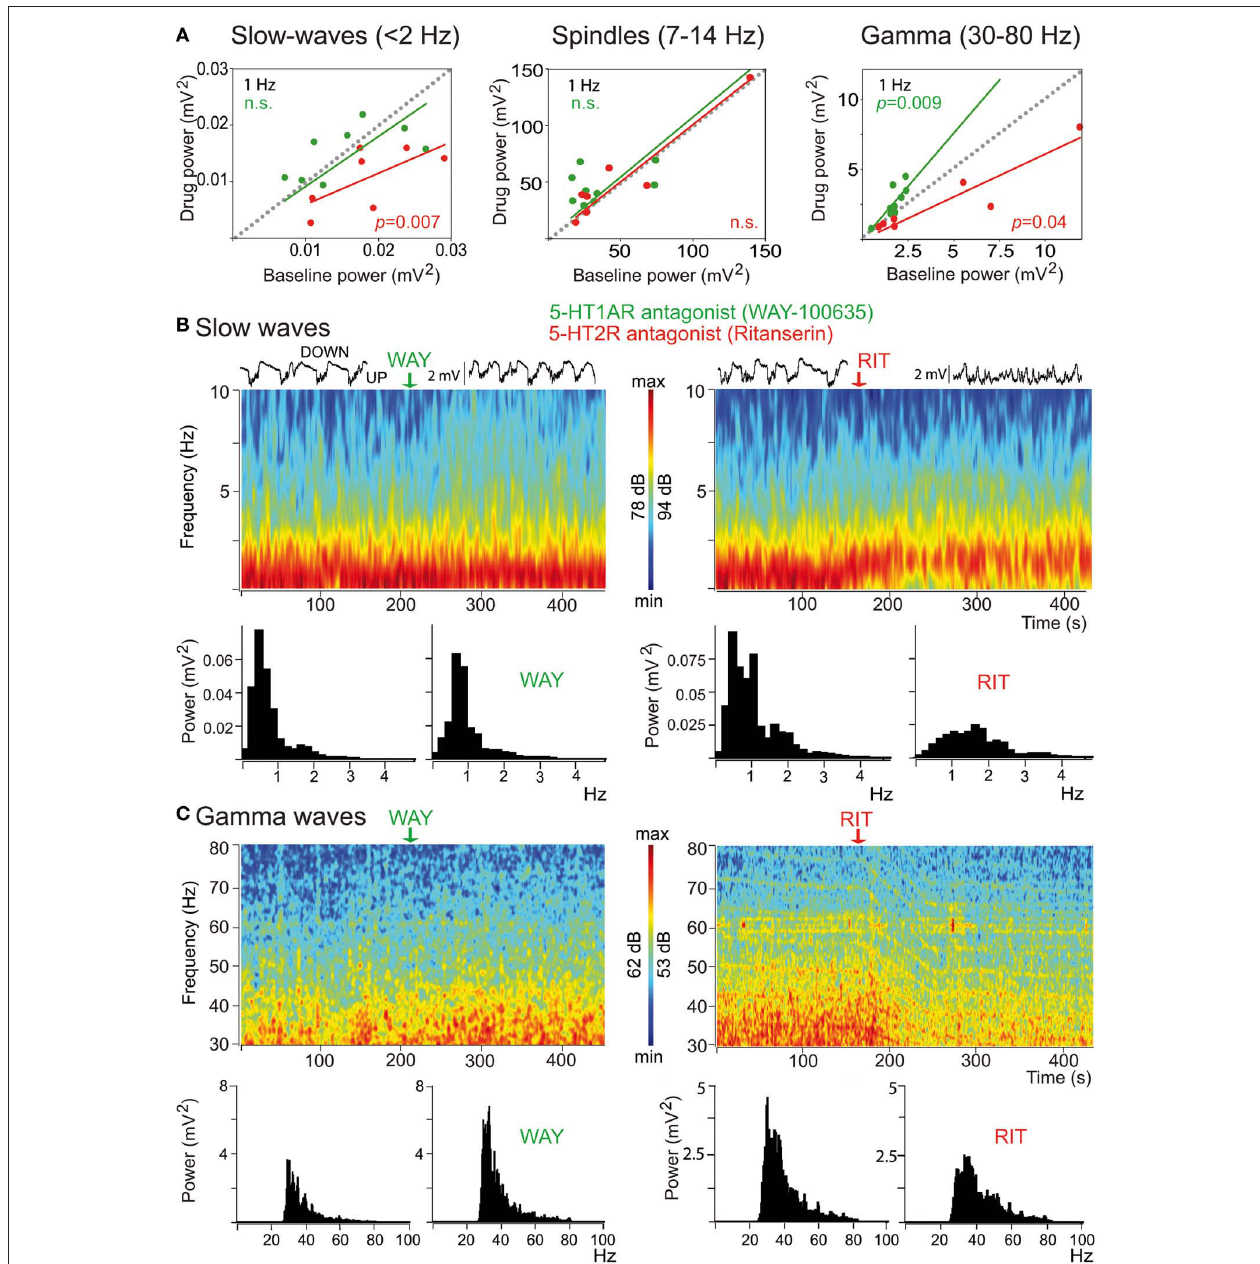
FIGURE 8 | Distinct modulation of cortical synchrony by 5-HT 1A and 5-HT 2A / 2C receptors. (A) Effects of the 5-HT 1A antagonist WAY (green) and the 5-HT 2A / 2C R antagonists ritanserin (RIT, red) on the baseline power (comparison of 30s epochs before and after drug injection) of slow, spindle, and gamma oscillations. Note the opposing actions of the two drugs on the power of gamma oscillations. (B) Examples of the effects of WAY and RIT on the power of slow waves. Time-frequency